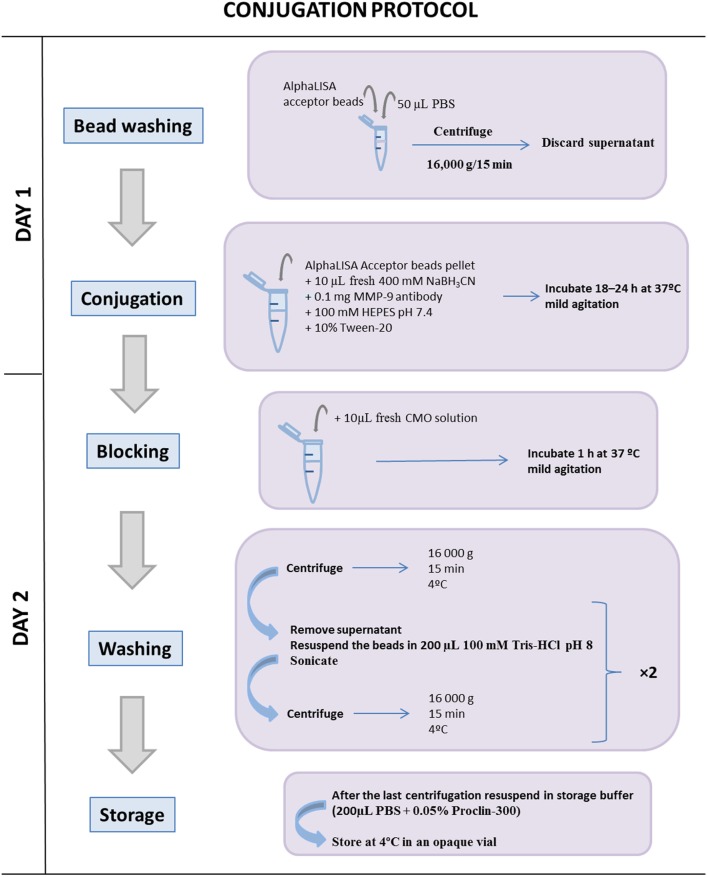
Schematic illustration of the conjugation protocol between the AlphaLISA® acceptor bead and the matrix metalloproteinase (MMP)-9 antibody. Once the acceptor beads and the MMP-9 antibody are coupled, it is important to block free acceptor bead-binding sites to avoid further interactions with other antibodies. One conjugation between 1 mg AlphaLISA® acceptor beads and 0.1 mg MMP-9 antibody reaches for a total 2,000 different interaction assays during 12 months.